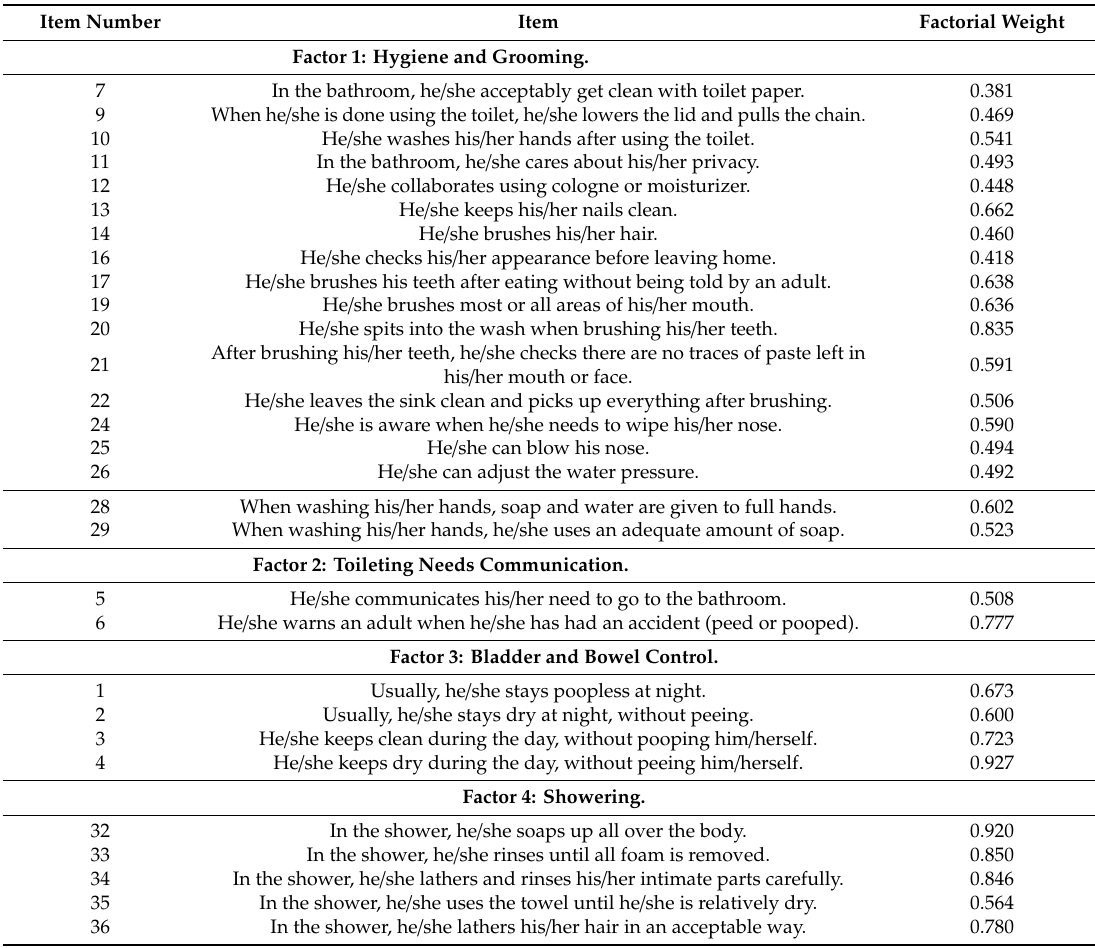
Table 7. Personal Hygiene scale factorial